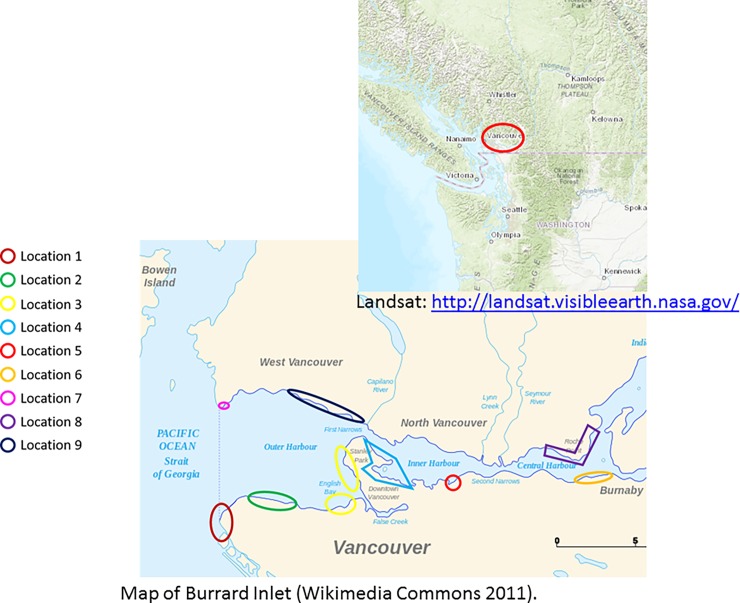
Location of the 9 urban intertidal regions sampled for plastics within Burrard Inlet, Vancouver, B.C. Insert in upper left hand corner indicates location relative to the rest of the Salish Sea, Canada.